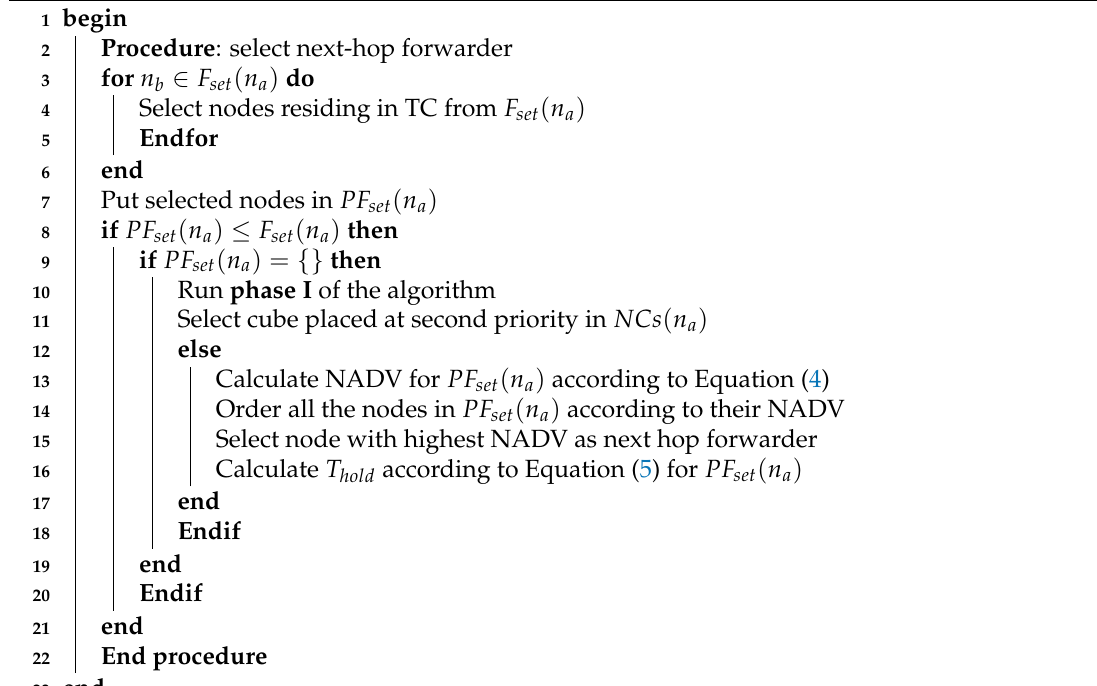
Algorithm 2: Next-hop forwarder